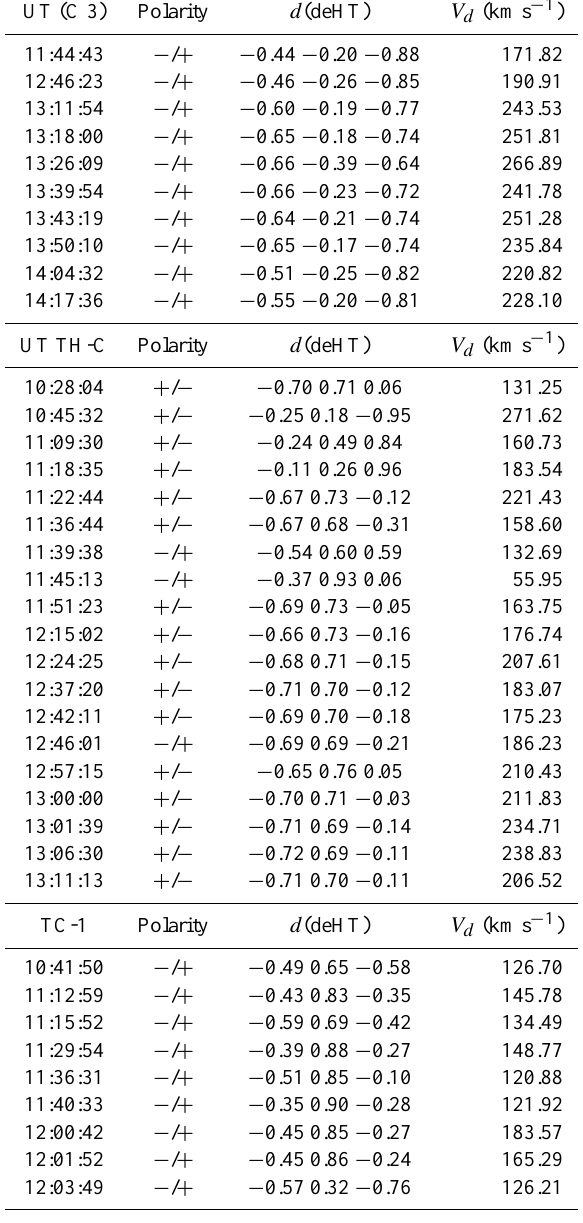
Table 2. The direction of motion ( d ) and speed ( V d ) of the FTE signatures, using de Hoffmann-Teller analysis, seen during the 3 May 2007 event shown for (a) Cluster-3 and (b) THEMIS-C. Here the IMF was directed into − B y